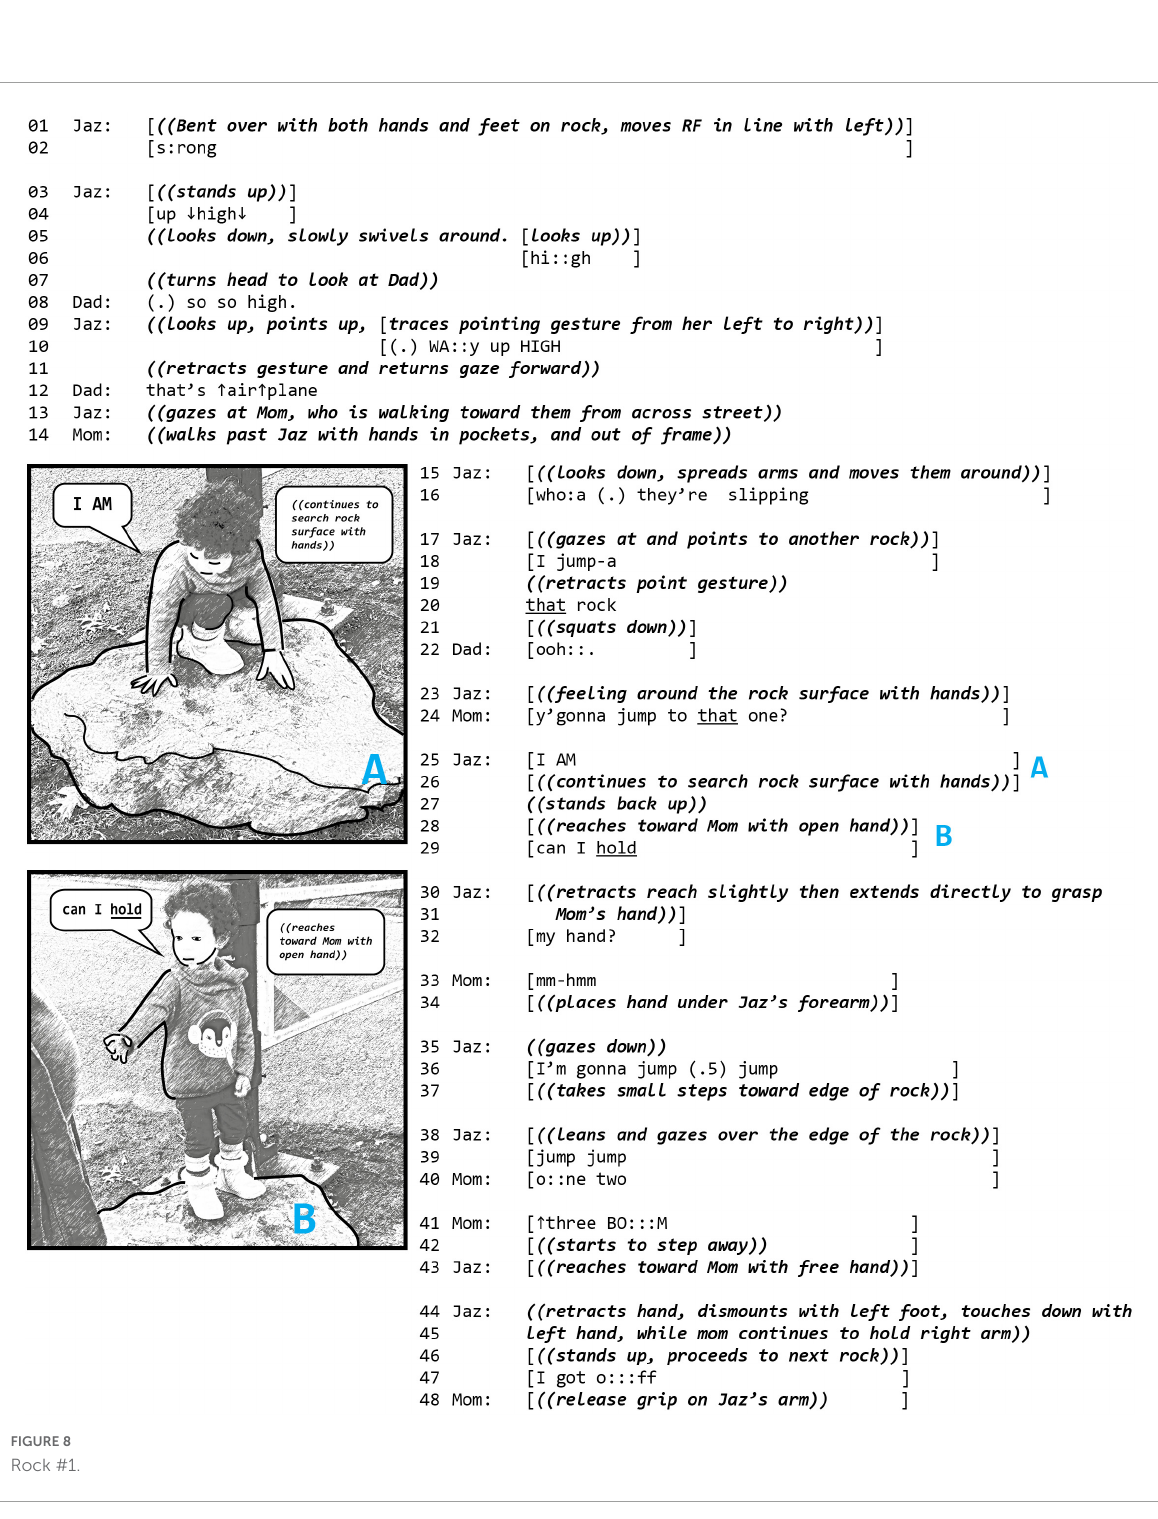
surface with multiple hand and foot placements [ENACTS STRATEGY]